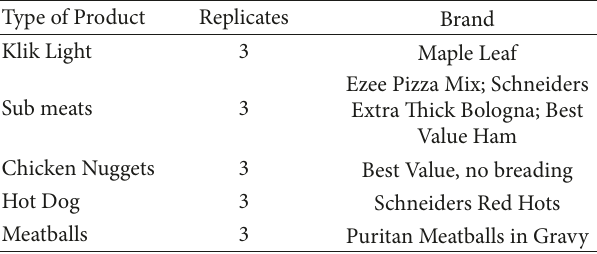
Table 1: Processed Meat Collected for AA Analysis.